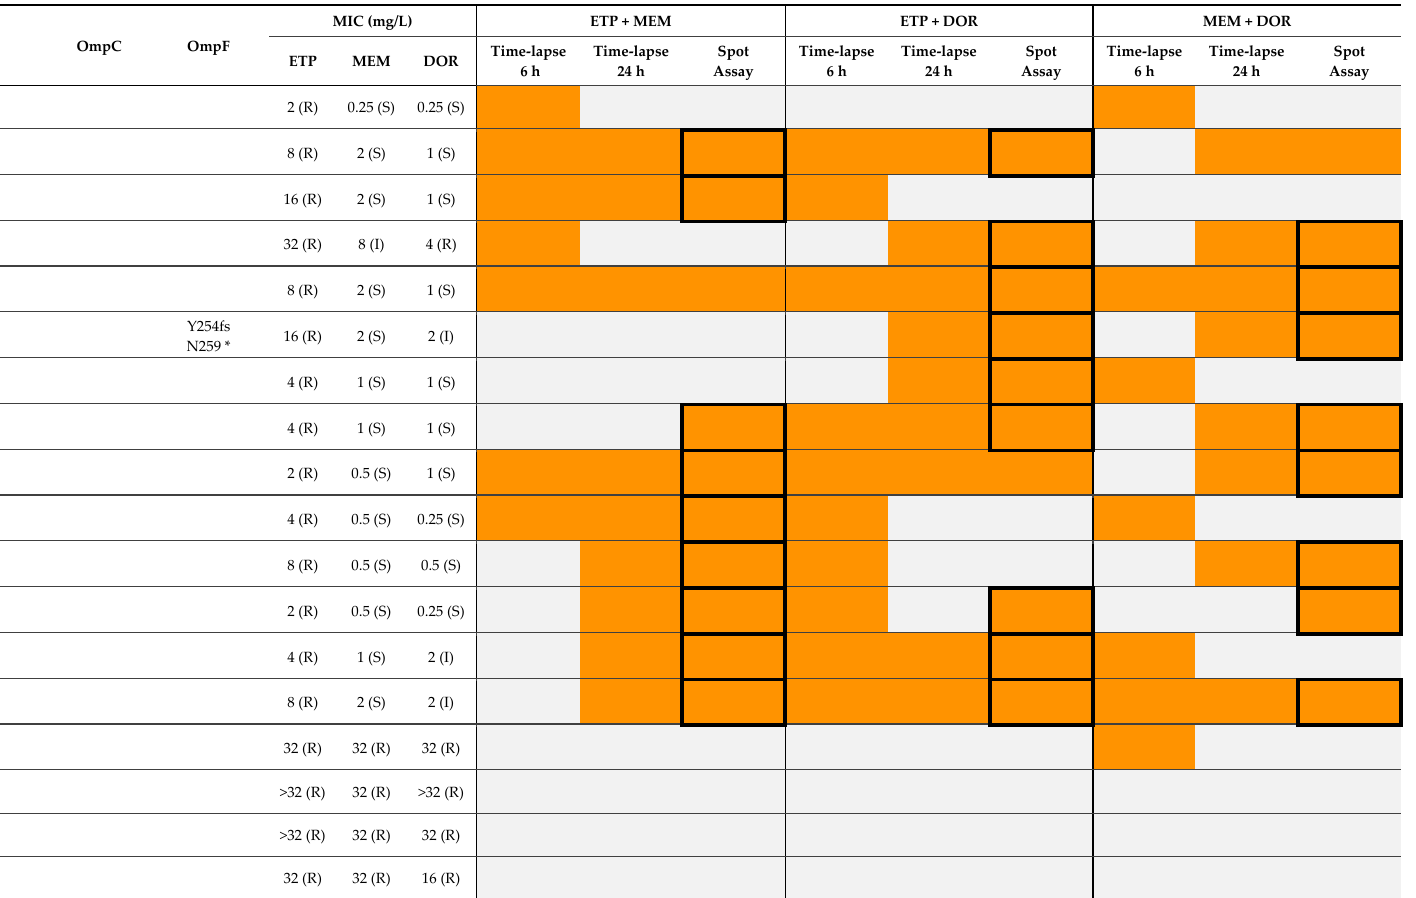
Table 1. Summary of results from time-lapse microscopy experiments (6 and 24 h) and spot assay (24 h) for double-carbapenem combinations against clinical carbapenemase-producing E. coli . MIC values for ertapenem, meropenem, and doripenem are classified according to EUCAST clinical breakpoints, version 12.0. Amino acid changes in β -lactamases are written in parentheses. Detected loss of function mutations in porin-encoding genes (OmpC/F) are presented. Carbapenem combinations showing an enhanced effect in the time-lapse microscopy experiments or synergy in the spot assay are highlighted in orange. Synergistic combinations that also showed a bactericidal effect are marked with a thick outline.